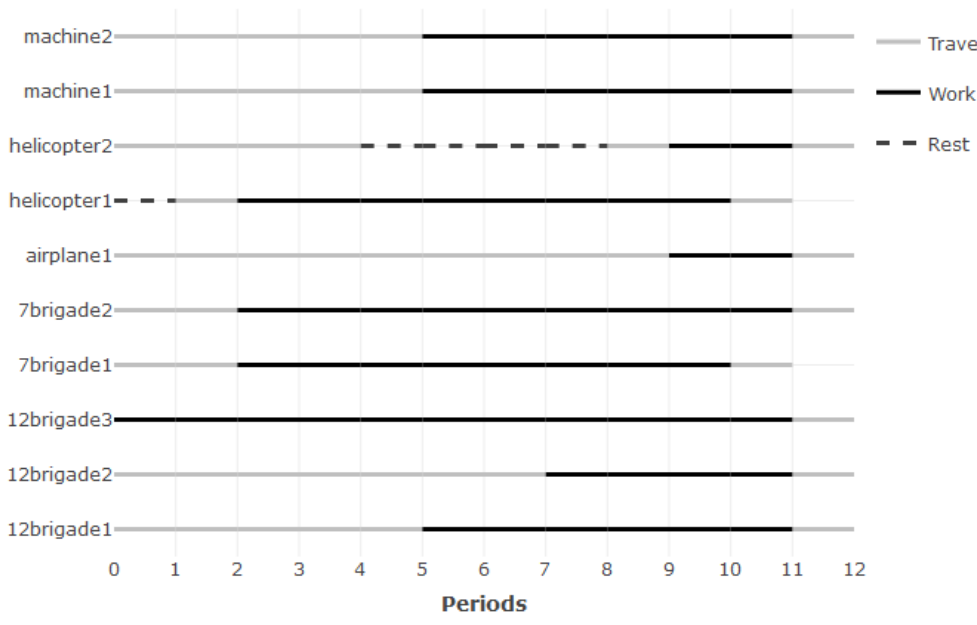
Figure 1. Scheduling of selected resources to fight the test